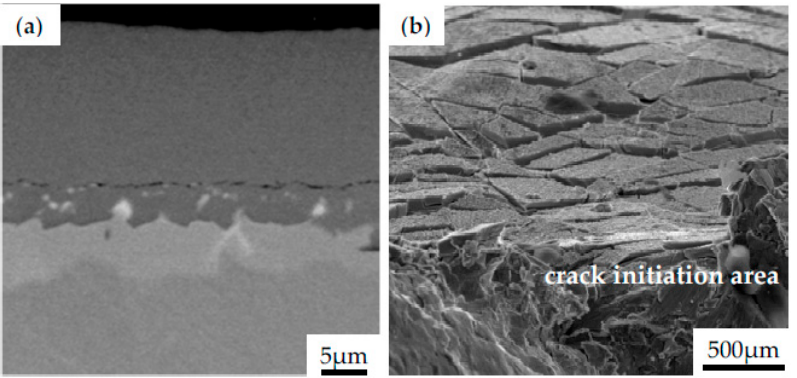
Figure 9. The morphology of Inconel 740 with NiAl coating obtained during CVD process after preparation of metallographic specimen ( a ), top view of the NiAl coating after fracture of the specimen subjected to cyclic loading ( b ).